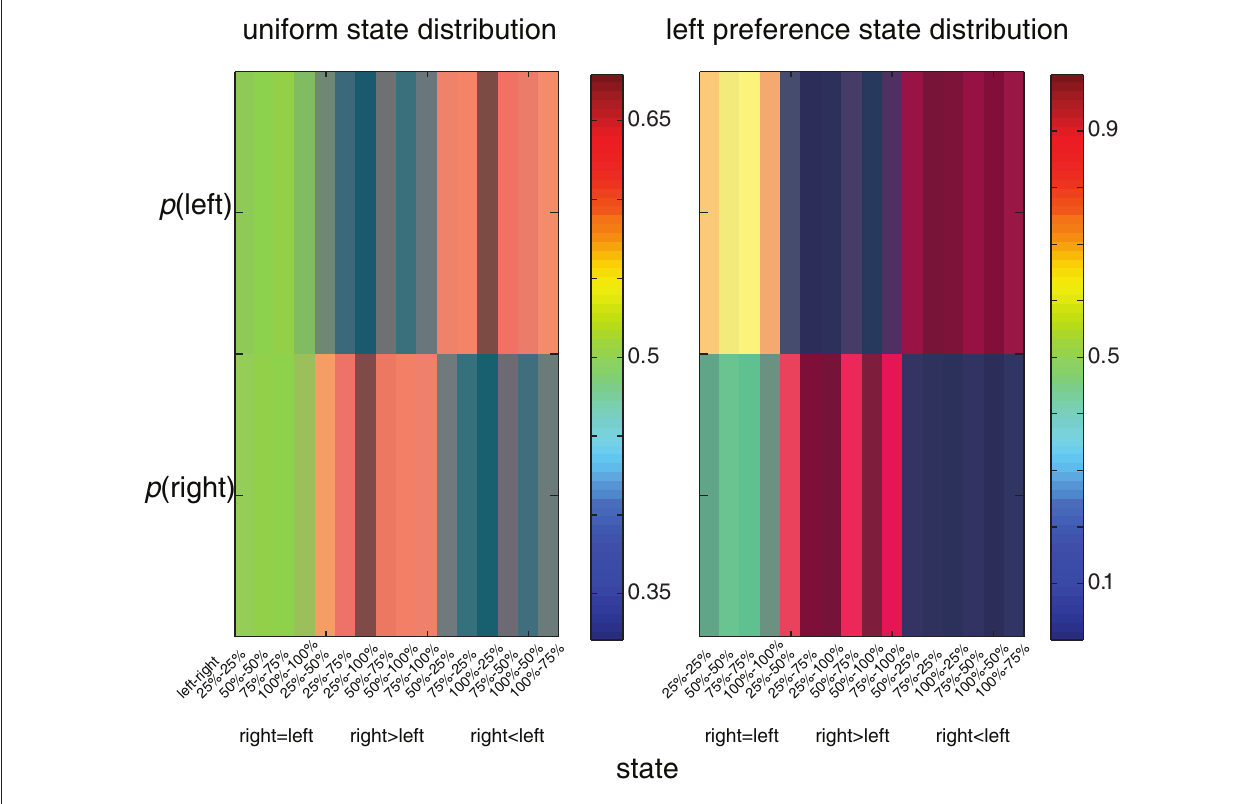
appear twice as often as states with a higher reward probability on the right. In the right column there is a clear preference for the left side (e.g., the policy prefers the left over the right side in states with equal reward probability on both